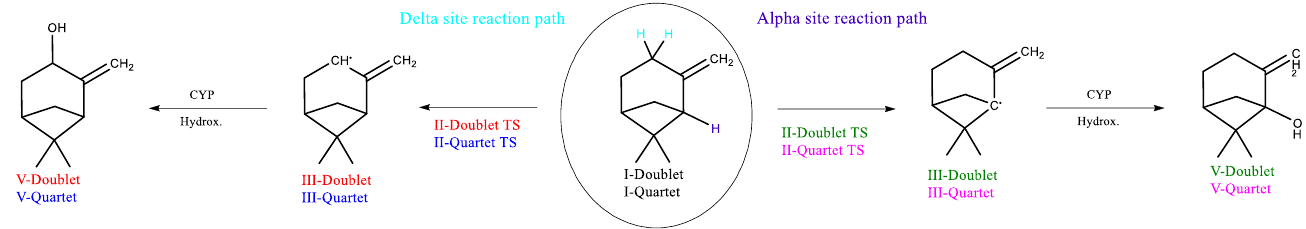
Figure 3. CYP- catalyzed hydroxylation of allylic sites of β -pinene. Figure 3. CYP-catalyzed hydroxylation of allylic sites of β -pinene.